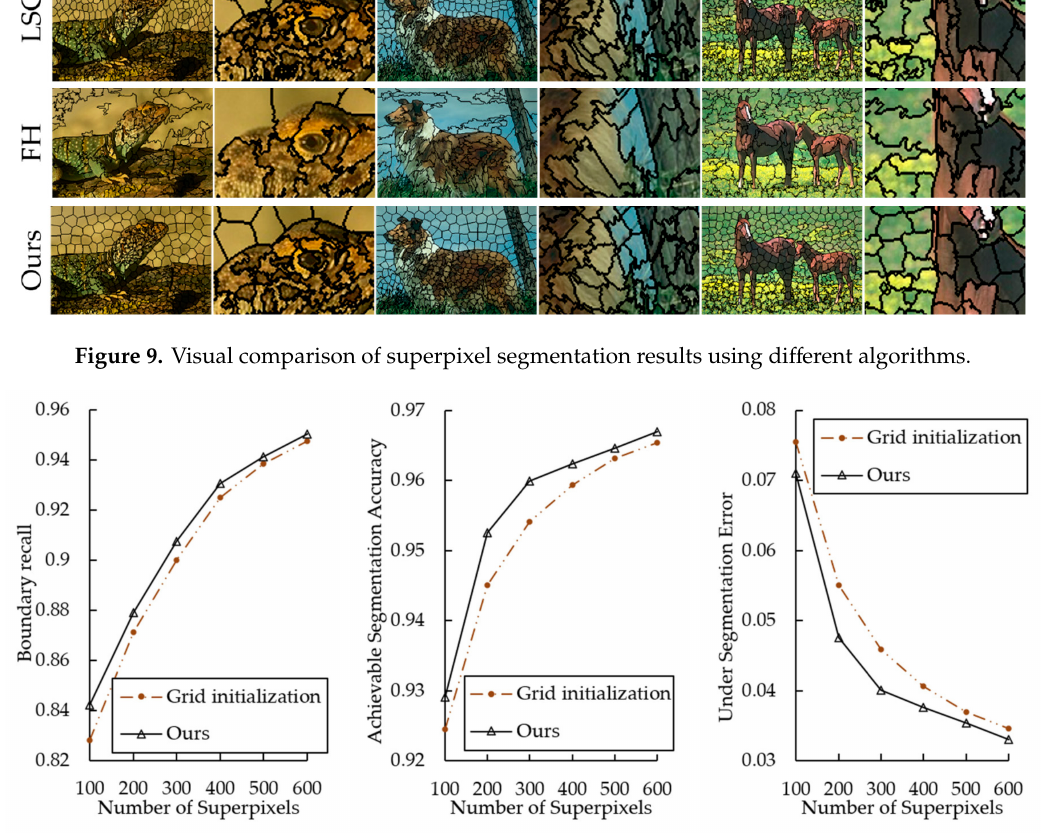
Figure 10. The metrics value comparison of our seed sampling strategy and grid initializations.